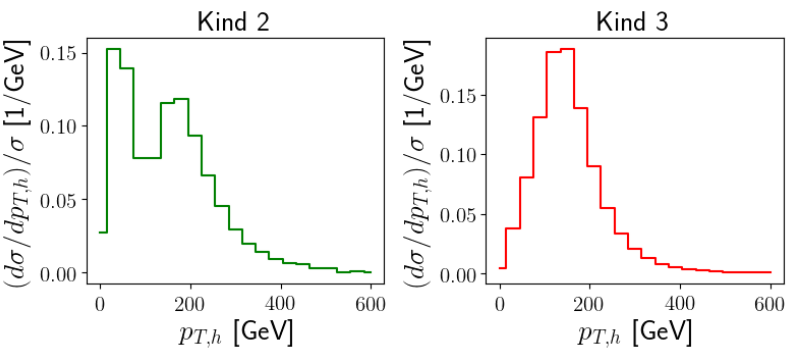
Figure 7 . Examples of p T;h distributions with a single or double peak.